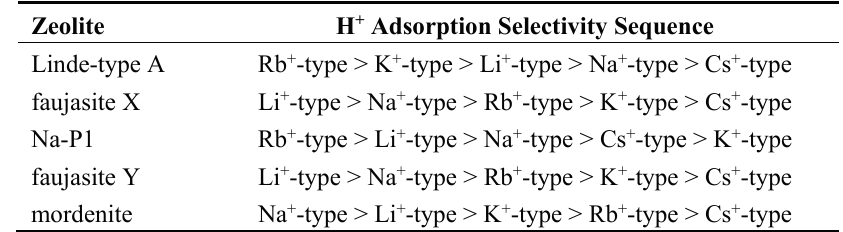
Table 3. Proton adsorption selectivity sequences of zeolites: the effect of saturation cation